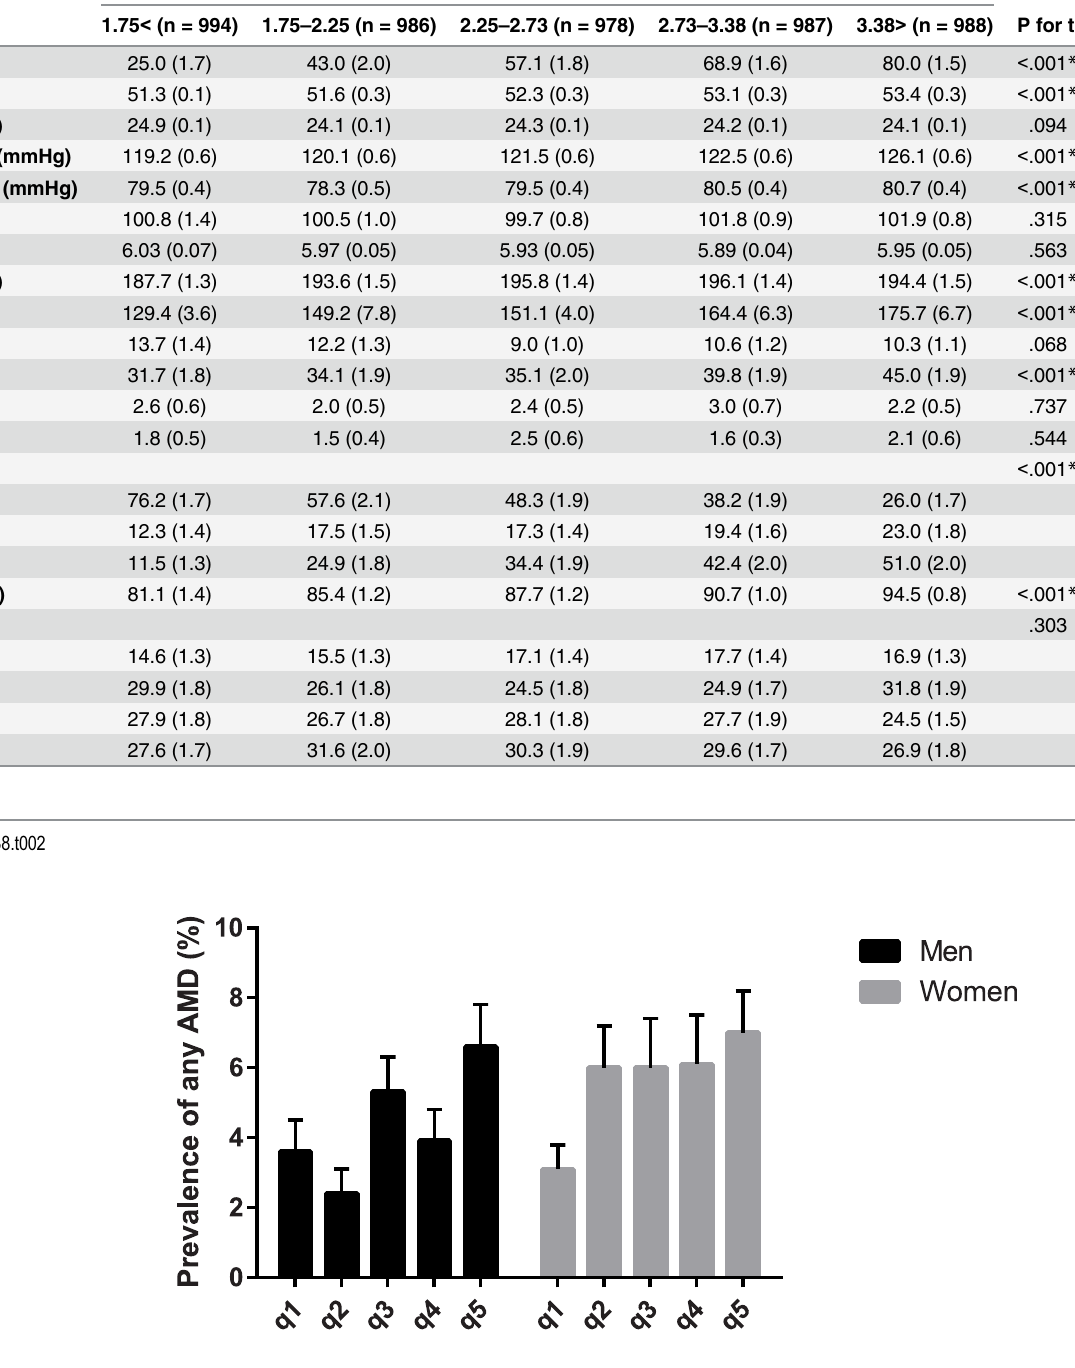
Table 2. Demographic and clinical characteristics by quintile blood lead category among representative Korean adults aged 40 years or older included in the study. Characteristics